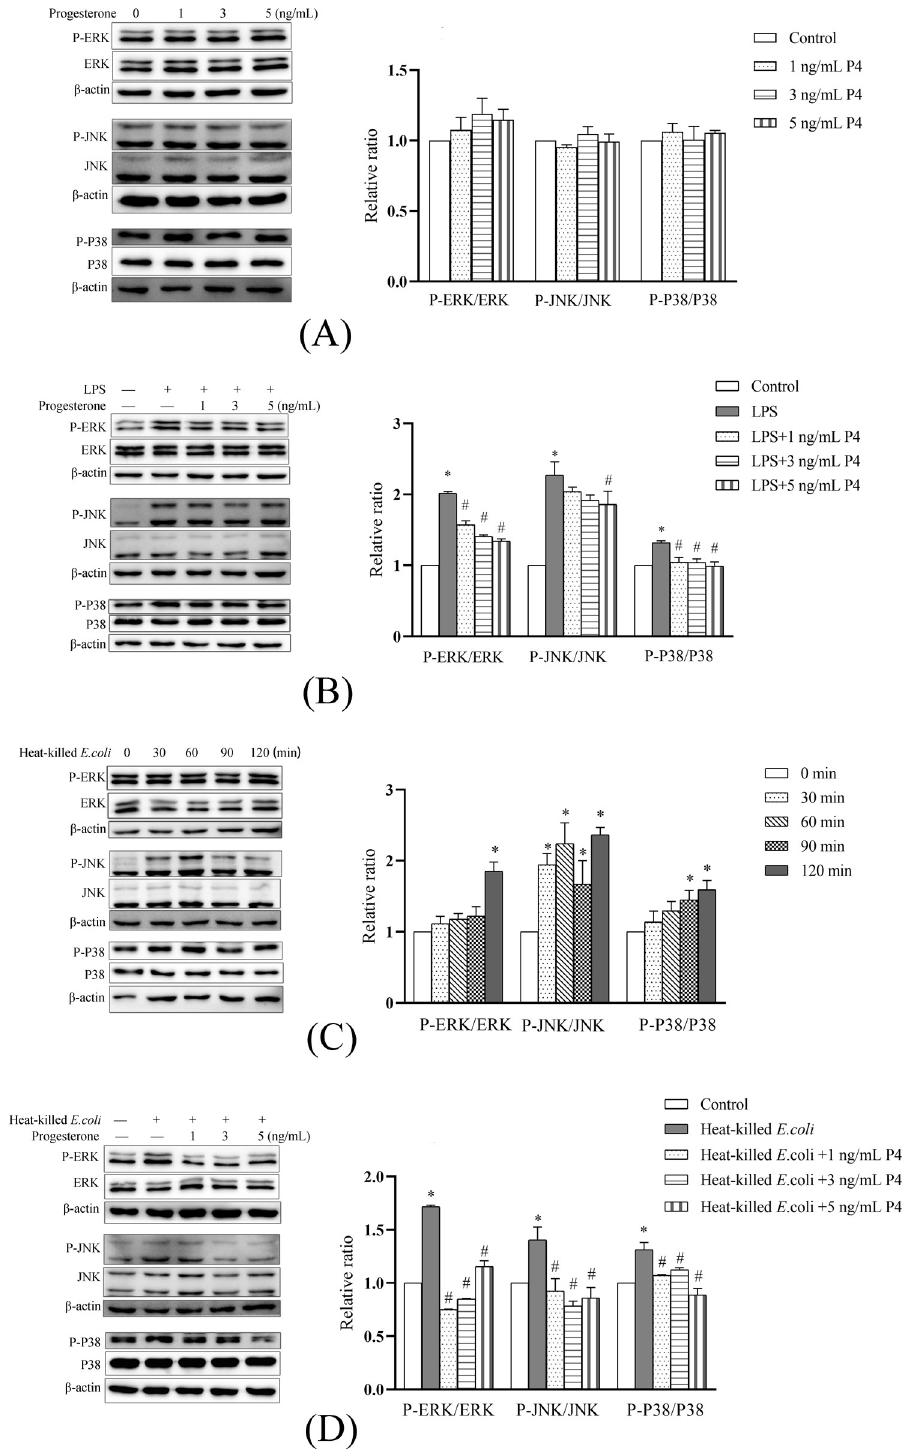
Fig 5. Progesterone suppressed phosphorylations of ERK, JNK, and P38 in primary bovine endometrial stromal cells in response to lipopolysaccharide or heat-killed E . coli stimulation. The protein levels of ERK, P-ERK, JNK, P-JNK, P38, and P-P38 was determined using Western blot. The blots were quantified by Quantity One software. A. Unstimulated cells were treated with 1, 3, and 5 ng/mL progesterone for 30 min. B. The cells were cotreated with 1 μ g/ mL lipopolysaccharide and progesterone (1, 3, or 5 ng/mL) for 60 min. The time point was based on the results of our